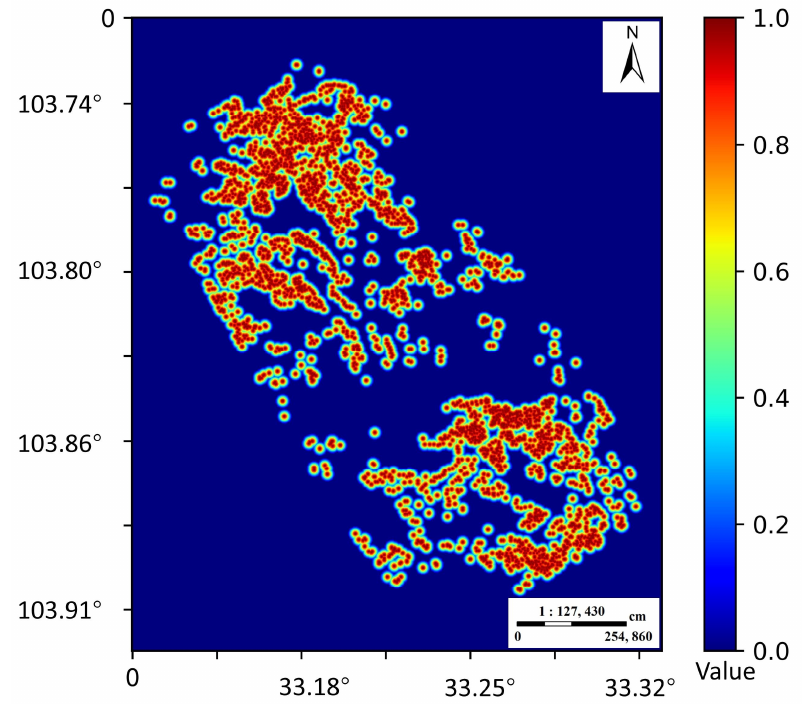
Figure 7. Gaussian heatmap of the Jiuzhaigou earthquake landslide.